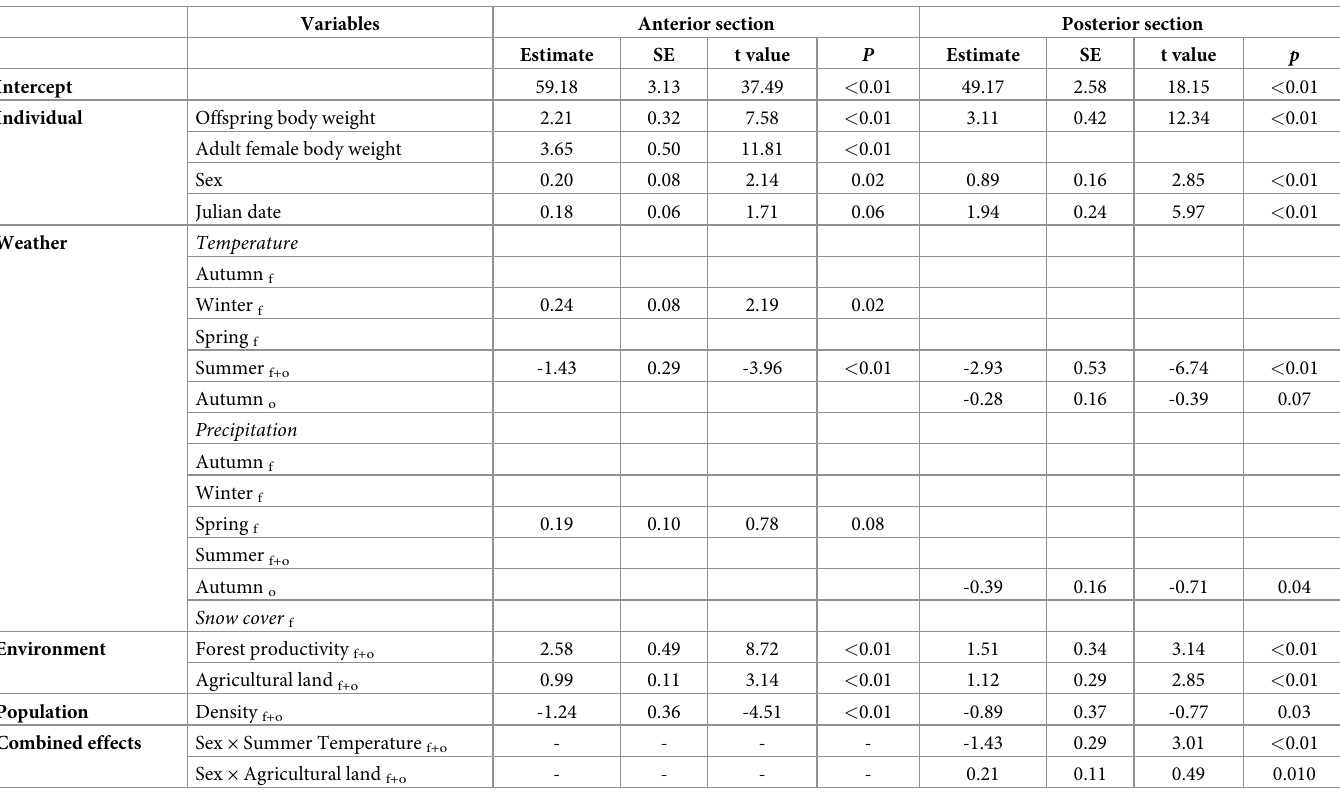
Table 2. Averaged